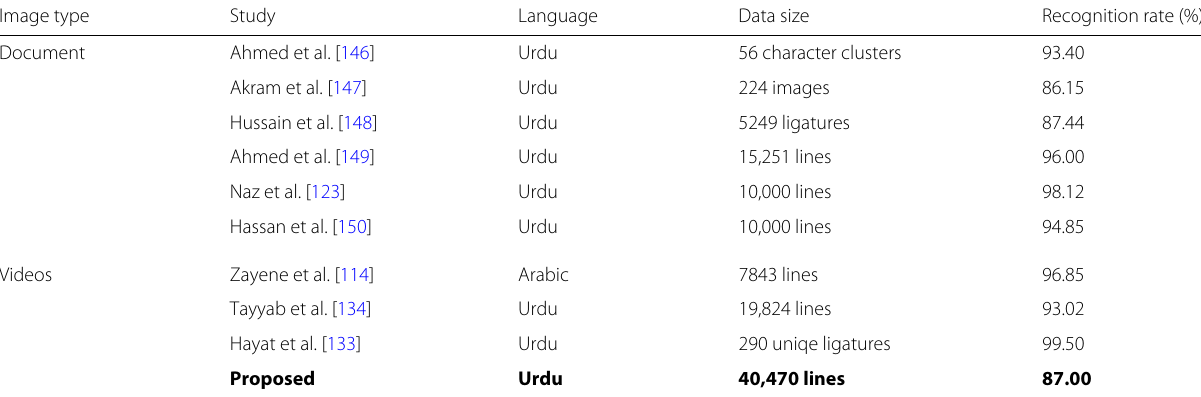
Table 8 Text detection performance comparison with other techniques Image